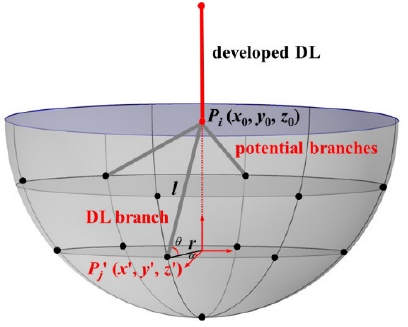
Figure 13. Leader development of dielectric breakdown model.